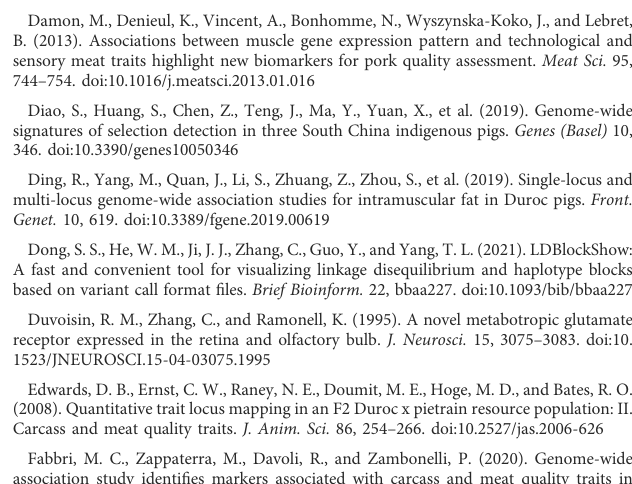
SUPPLEMENTARY FIGURE S1 Establishment fl ow plot of (Duroc×Saba) × [Yorkshire × (Landrace × Saba)] crossbred pig population. SUPPLEMENTARY FIGURE S2 Frequency distribution histogram for six meat quality traits. (A) PH at 45 min